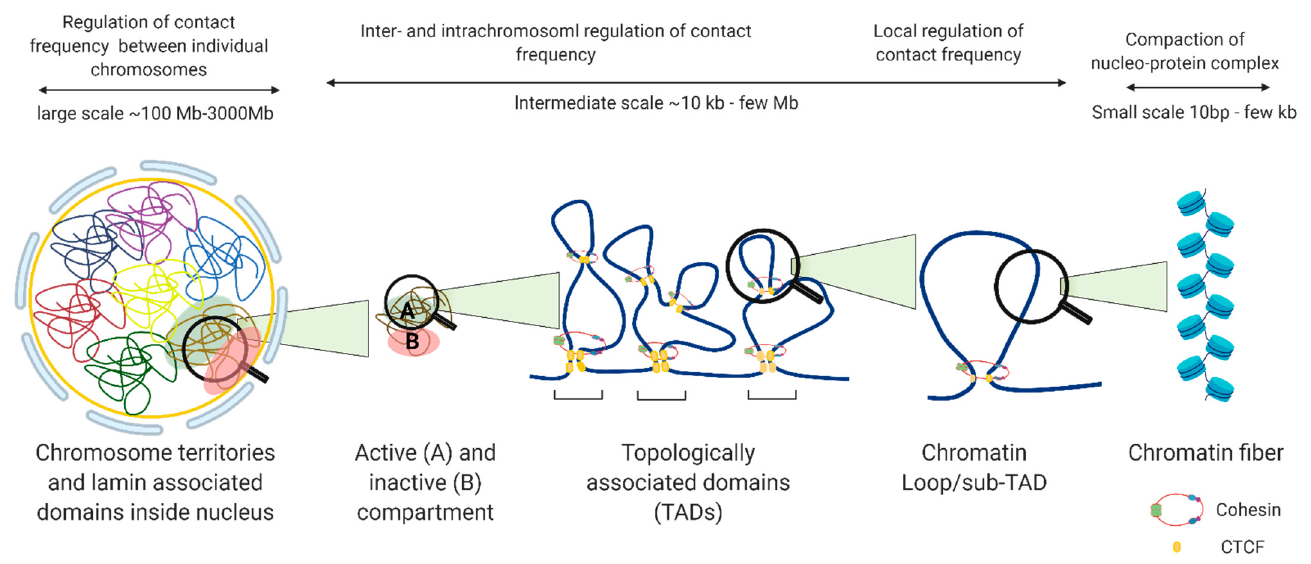
Figure 2. Levels of nuclear genome organization in interphase cells.